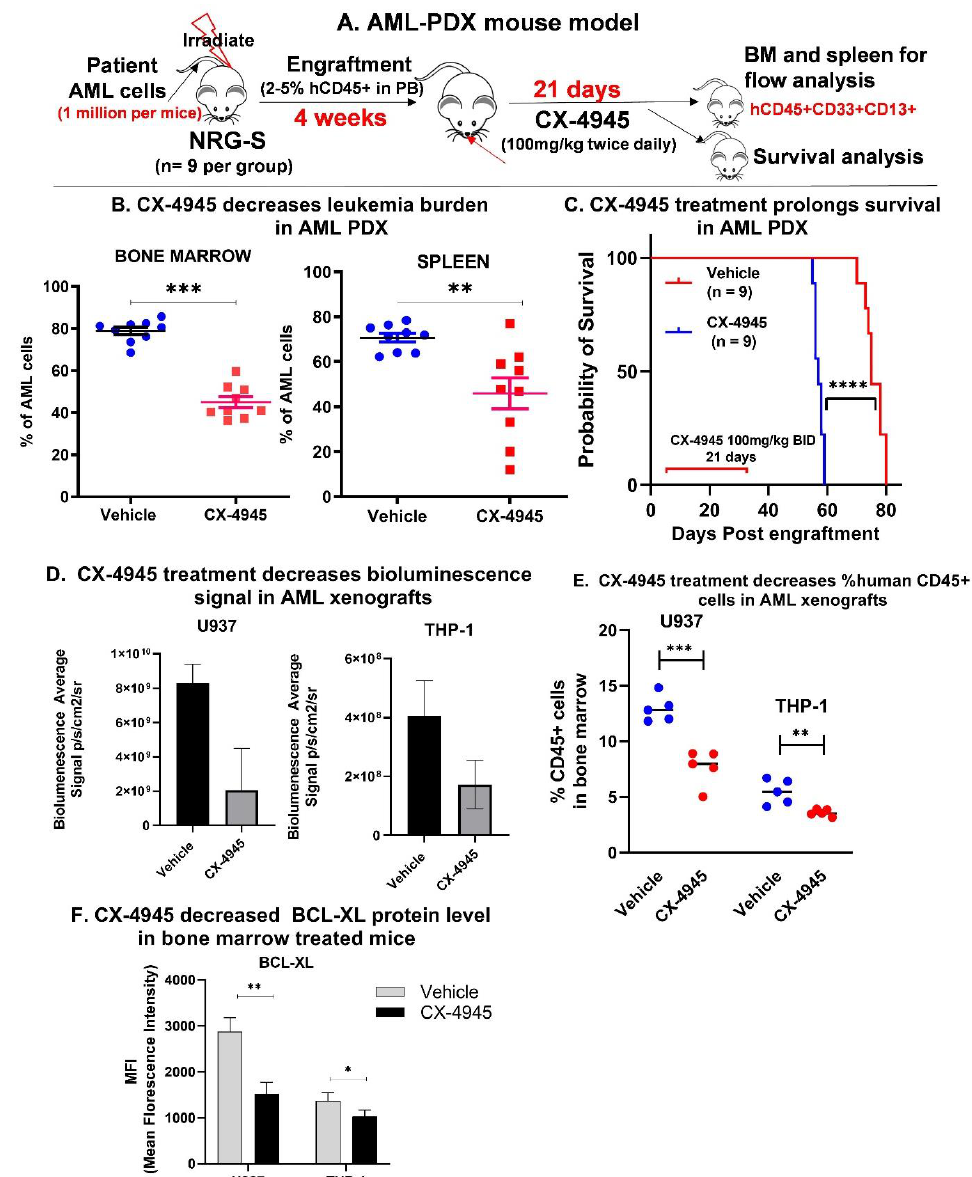
Figure 3. CX-4945 treatment shows therapeutic efficacy in AML Patient Derived Xenograft (PDX). ( A ) Schema showing AML PDX generation and treatment. AML-1 PDX was developed by injecting NRG-S mice with one million cells per mouse via the tail vein. Treatment was started when 2–5% human CD45+ cells were detected in peripheral blood (PB). Mice received 100 mg/kg of CX-4945 via gavage twice daily for 21 days. ( B ) Percent AML (human CD45+, CD13+,CD33+) in bone marrow (BM) and spleen of treated and untreated AML-1 PDX mice by flow cytometry. ( C ) Kaplan Maier plot showing survival probability of treated and untreated AML-1 PDX mice. Cell line derived xenograft (CDX) mouse models was developed using luciferase, and green fluro-protein (gfp) labeled U937 cells (U937-gfp-luc) or THP-1 cells (THP1-gfp-luc) transplanted into immunocompromised NRG-S mice as described in methods. Mice were treated with vehicle or CX-4945 at a dose of 100 mg/kg twice daily via gavage for up to 7 days. ( D ) Engraftment was monitored using bioluminescence imaging shown as the mean of the total flux in photons/second of mice in each group. ( E ) Following treatment, mice were sacrificed, and bone marrow mononuclear cells were collected. Human CD45+ cells in bone marrow were measured using flow cytometry. Flow cytometry using conjugated BCL-XL antibody was used to quantify intracellular BCL-XL protein level in FACS enriched human CD45+cells in the bone marrow of treated and untreated mice. Figure S6 shows histogram of BCL-XL and CK2 α protein level in vehicle and CX-4945 treated U937 and THP-1 CDX. ( F ) Mean fluorescence intensity(MFI) is graphed, showing decreased BCL-XL protein level. P -value summaries are as follows: p > 0.05 (ns-not significant); 0.05 (*); p < 0.01 (**); p < 0.001 p ≤